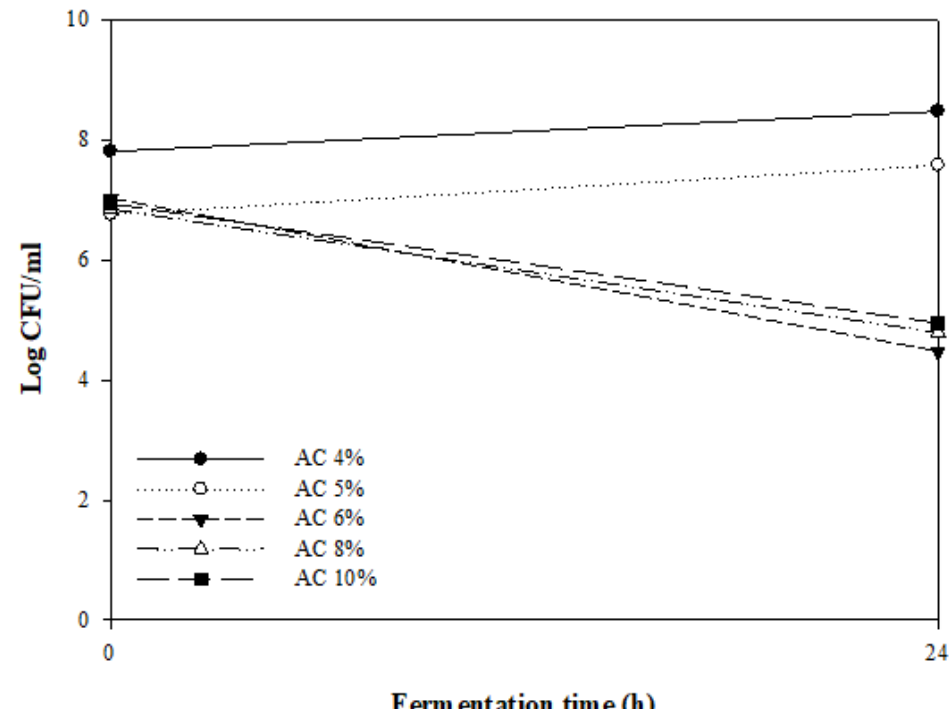
Figure 1. Changes in the viable cell counts of MKJW-fermented A. capillaris (AC) during 24 h. Figure 2 shows the number of viable bacteria and pH changes that occurred during 24 h with the addition of each G. bimaculatus and yeast extract to 5% A. capillaris . The addition of supplemental materials such as G. bimaculatus and yeast extract to A. capillaris enhanced the growth of MKJW to approximately 9 log CFU/mL compared to the 5% A. capillaris only (7.58 log CFU/mL) during 24 h fermentation. The pH of 5% A. capillaris decreased from 5.11 to 4.73 for 24 h; 5% A. capillaris supplemented with 2% G. bimaculatus decreased from 5.45 to 3.66 after fermentation; 5% A. capillaris supplemented with 2% yeast extract decreased from 5.32 to 4.00; and 5% A. capillaris supplemented with 1% G. bimaculatus and 1% yeast extract decreased from 5.36 to 3.83.